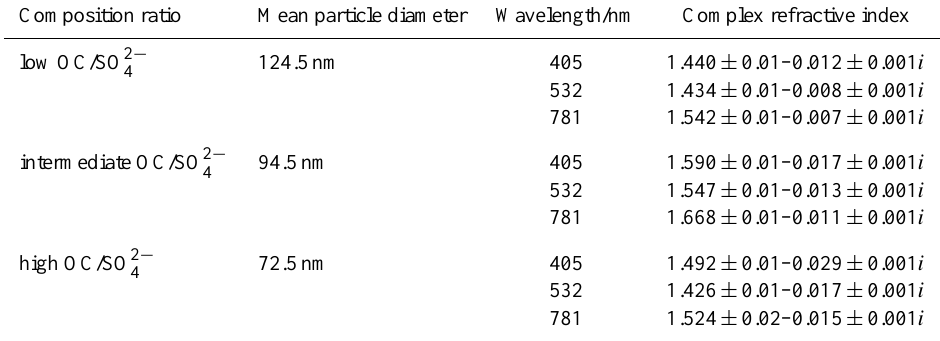
Table 4. Mean particle diameters and complex refractive indices for the low, intermediate, and high OC/SO 2 − complex refractive indices are calculated from an iterative procedure constrained by observed wavelength dependent optical properties, discussed in the text. The mean particle diameters are calculated from the merged particle number size distributions in each of the low, intermediate, and high OC/SO 2 − 4